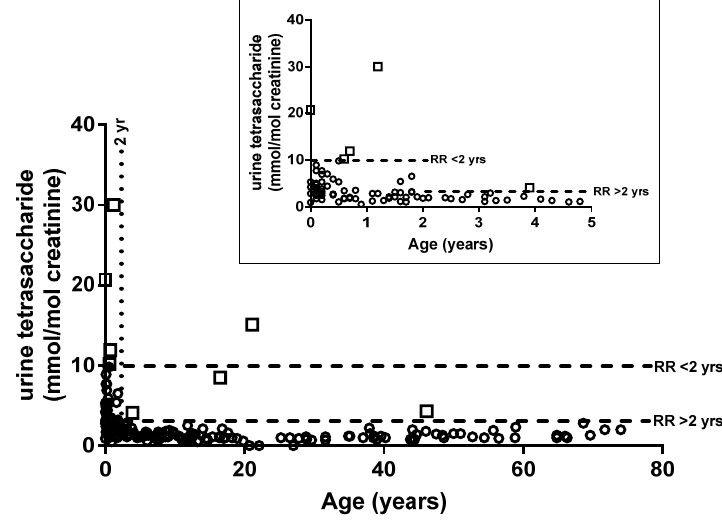
Figure 2. Age-related reference intervals. Urine tetrasaccharide concentrations for 190 individuals without Pompe disease. Inset shows expanded results for individuals < 5 years old. White squares indicate individuals with concentrations above the reference interval. RR, reference range.